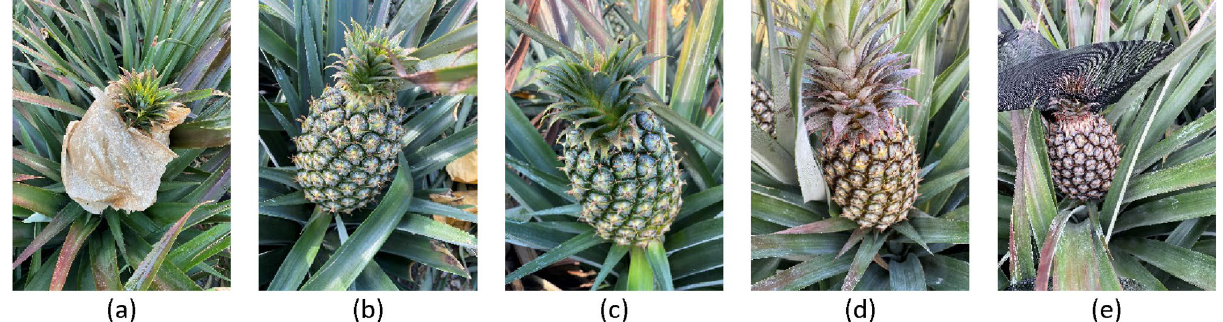
Figure 4. Database categories: ( a ) bag; ( b ) ripe; ( c ) ripening; ( d ) unripe; ( e )